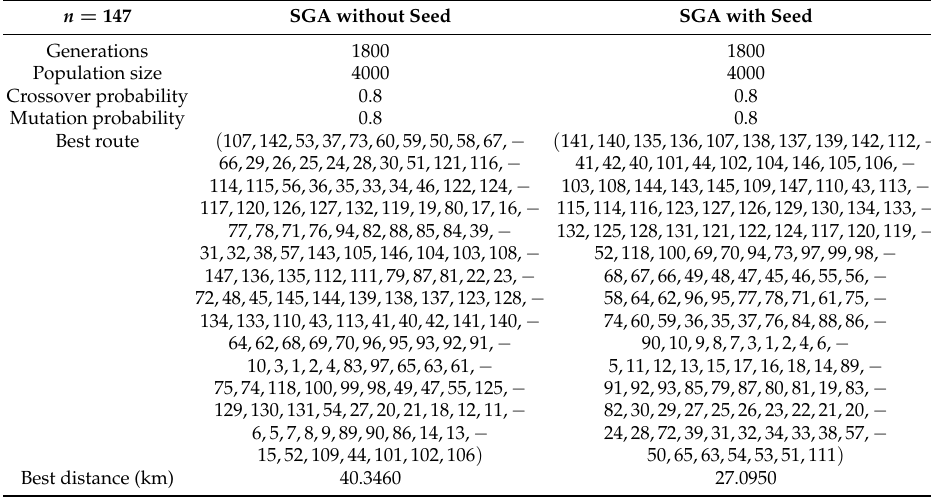
Table 13. Results of the n = 147 problem.